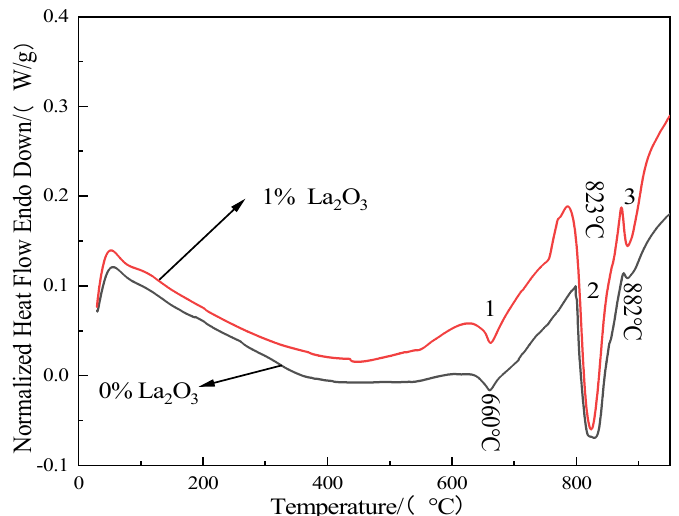
Figure 5. Differential thermal analysis curves with and without rare-earth La 2 O 3 in powder.